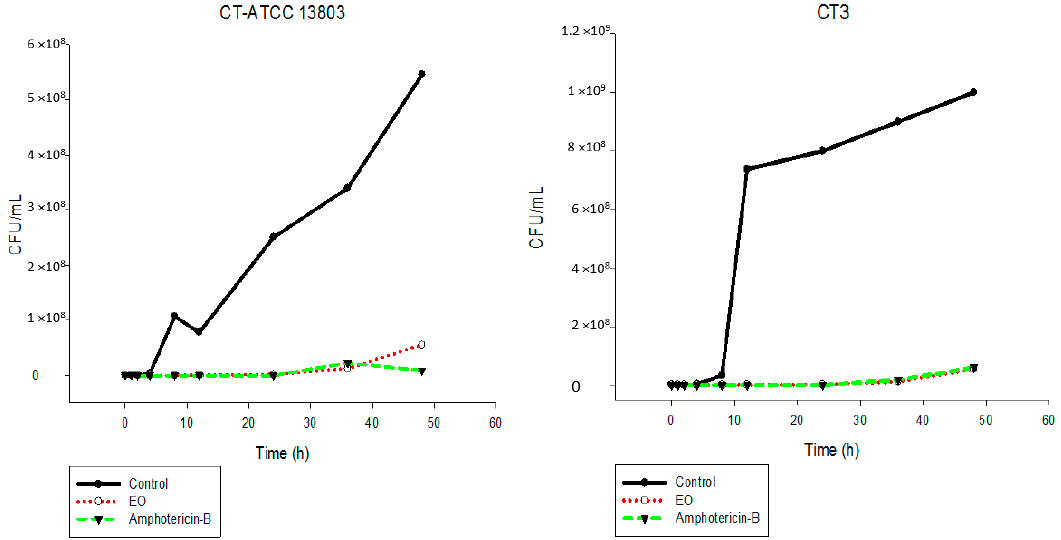
Figure 5. Time-kill curves of C. tropicalis ATCC 13803 and CT3 following exposure to the essential oil of C. nardus and amphotericin-B. Control represents the untreated Candida cells.